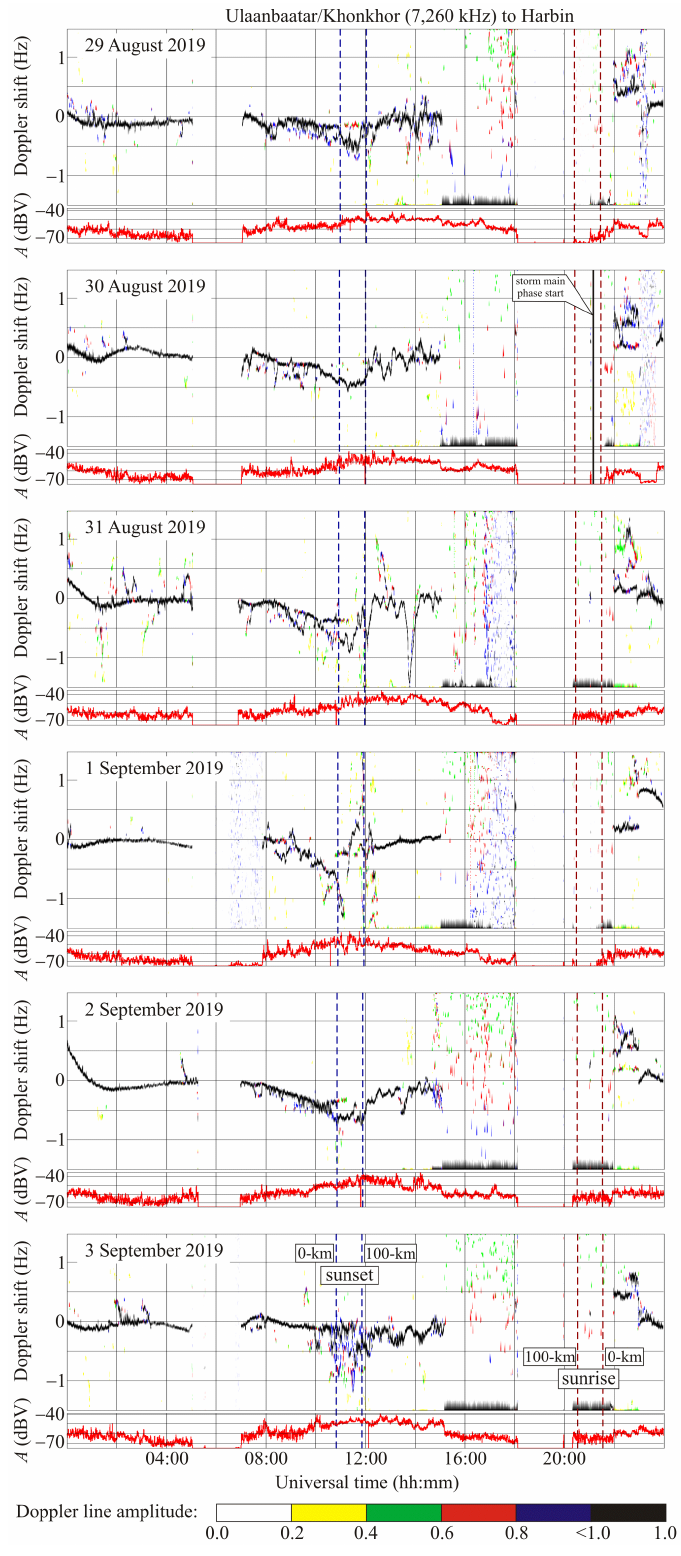
Figure 10. Same as Fig. 5 but for the Ulaanbaatar/Khonkhor to Harbin radio wave propagation path at